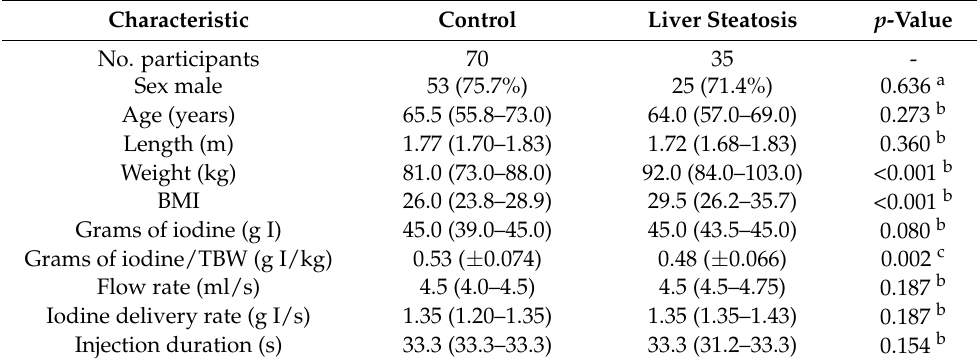
Table 1. Baseline characteristics.